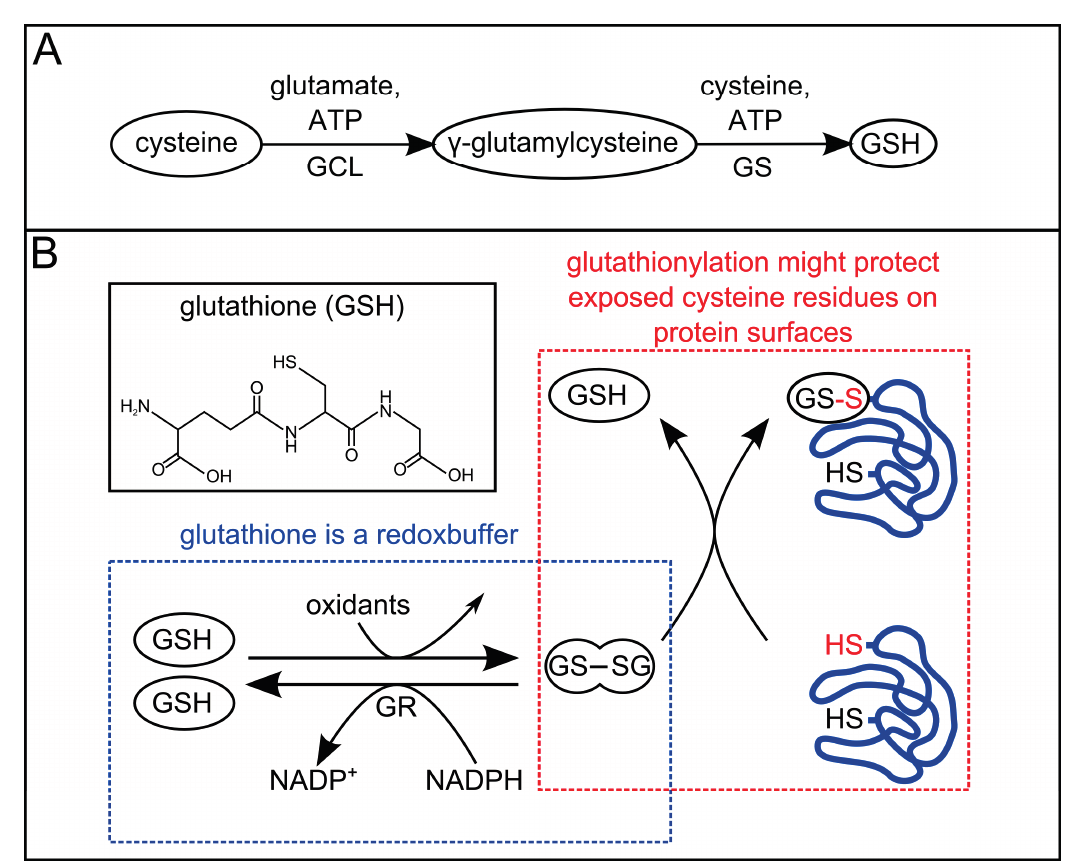
Figure 6. Glutathione biosynthesis and function: ( A ) Cysteine and glutamate are enzymatically linked to γ -glutamylcysteine via the action of glutamate cysteine ligase (GCL). The next step in synthesis is the formation of glutathione itself from cysteine and γ -glutamylcysteine via glutathione synthetase (GS). ( B ) Glutathione can be oxidized to glutathione dimers (GSSG) and thereby serves to buffer oxidants within the cell. A shift in the equilibrium from GSH towards a higher proportion of GSSG may promote the glutathiolation of free cysteines on protein surfaces, thus shielding these cysteine residues during oxidative stress conditions from over-oxidation. Illustration was redrawn from